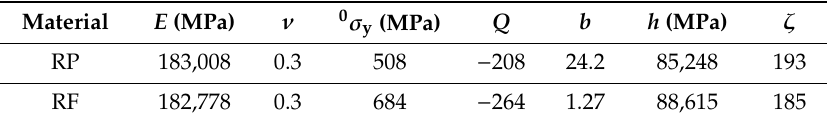
Table 4. Material properties used in finite element analysis (FEA).